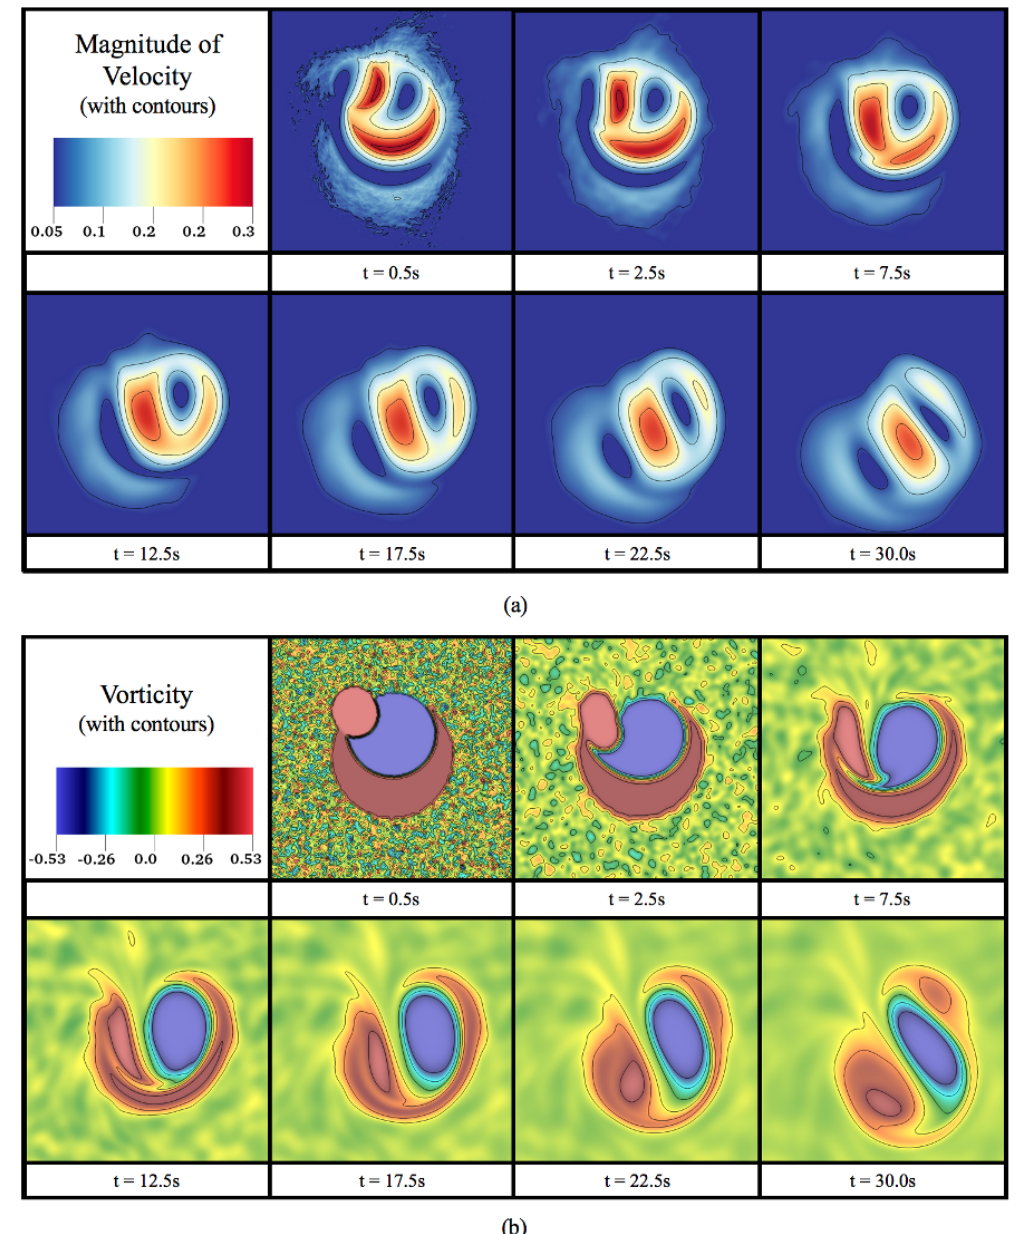
Figure A6. The evolution of ( a ) the magnitude of velocity (with its contours) and ( b ) vorticity (with its contours) during the course of the